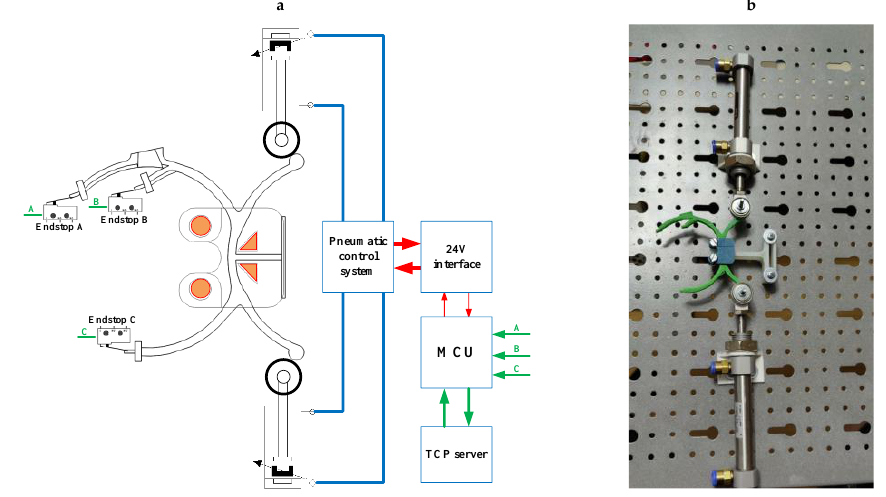
Figure 12. ( a )—Control schematics; ( b )—Real Figure 12. ( a ) — Control schematics; ( b ) — Real system.